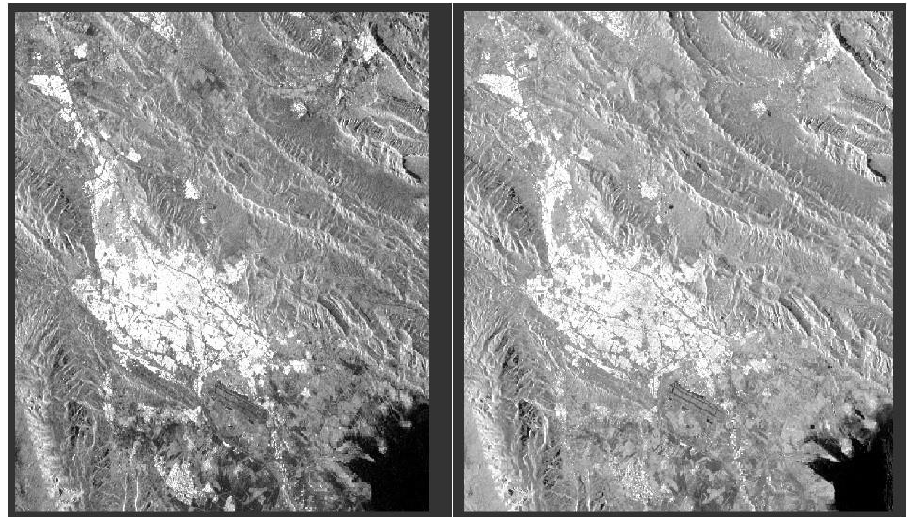
Figure 3. a) Intensity_VH polarization data (top left) b) Intensity_VV polarization data (top right) c) Saigma_0_VH_db polarization